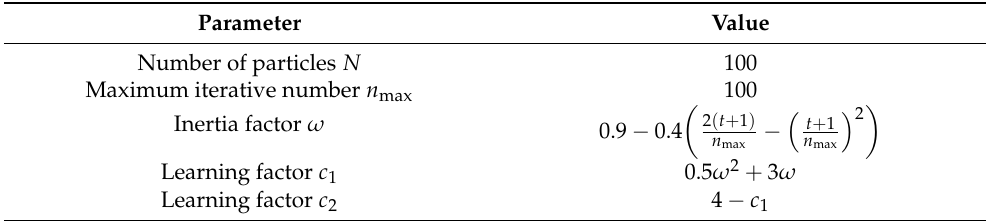
Table 2. The parameters of the MOPSO.